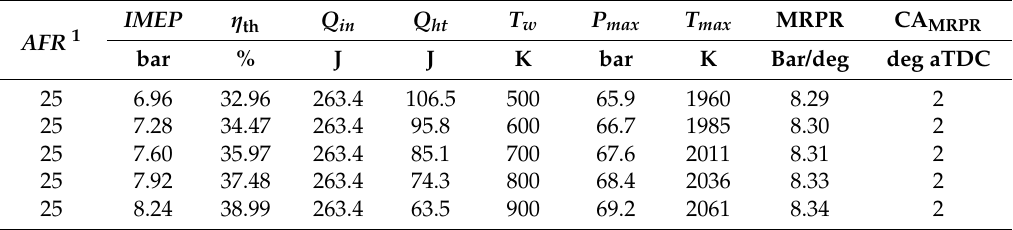
Table A1. Effects of wall temperature on the simulated results for combustion pattern 1.